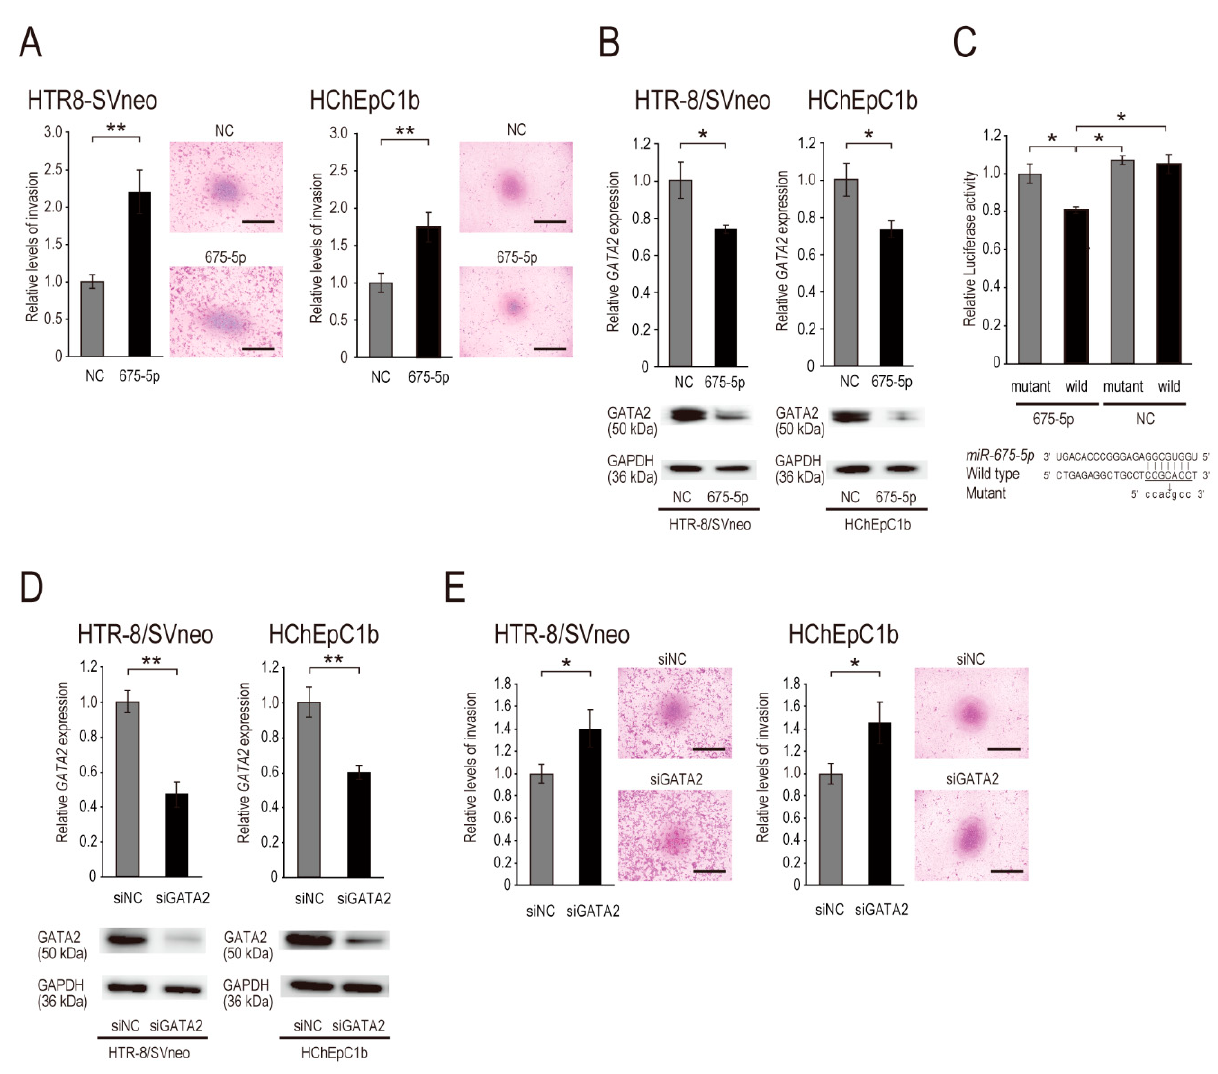
Figure 2. miR-675-5p accelerated the invasive ability of EVT cell lines via GATA2 inhibition. ( A ) Transwell invasion assay of EVT cell lines (HTR-8/SVneo and HChEpC1b) transfected with a miR-675-5p (675-5p) or negative control (NC) mimic. The number of invasive cells is expressed as a percentage of the control value, and the invasion level of NC mimic was set at 1.0. ( B , C ) Validation of GATA2 as a miR-675-5p target. ( B ) GATA2 mRNA (upper panel) and protein (lower panel) expression in EVT cell lines transfected with 50 nM 675-5p or NC mimic and cultured for 48 h. ( C ) GATA2 3 ′ -UTR luciferase reporter assay. A reporter vector (pMIR-GATA2/wild or pMIR-GATA2/mut) and miR mimic (20 nM 675-5p or NC) were co-transfected into cells. The Renilla luciferase vector pRL-TK was used as the internal control. Luciferase expression levels in cells co-transfected with pMIR-GATA2/mut and 675-5p were defined as 1.0. Sequences of the putative target site of miR-675-5p in the 3 ′ -UTR of GATA2 and the mutation introduced into the miR-675-5p recognition site of the 3 ′ -UTR in the reporter plasmid (lower panel). ( D ) Knockdown efficiency in EVT cell lines (HTR-8/SVneo and HChEpC1b) transfected with siGATA2. GATA2 mRNA and protein expression in EVT cell lines transfected with 20 nM siGATA2 or siNC and cultured for 24 h. ( E ) Transwell invasion assay with EVT cell lines transfected with siGATA2 or siNC. For the invasion assay, the number of invasive cells was expressed as a percentage of the control value, and the invasion level of siNC was set at 1.0. Normalization in qPCR was performed using 18S; GAPDH was used as the internal control in Western blotting. Data are presented as the mean ± SD of the results of three independent experiments. Student’s t -test ( A , B , D , E ) or Tukey’s test ( C ) was used to assess between-group differences; * p < 0.05, ** p < 0.01. Bars = 1